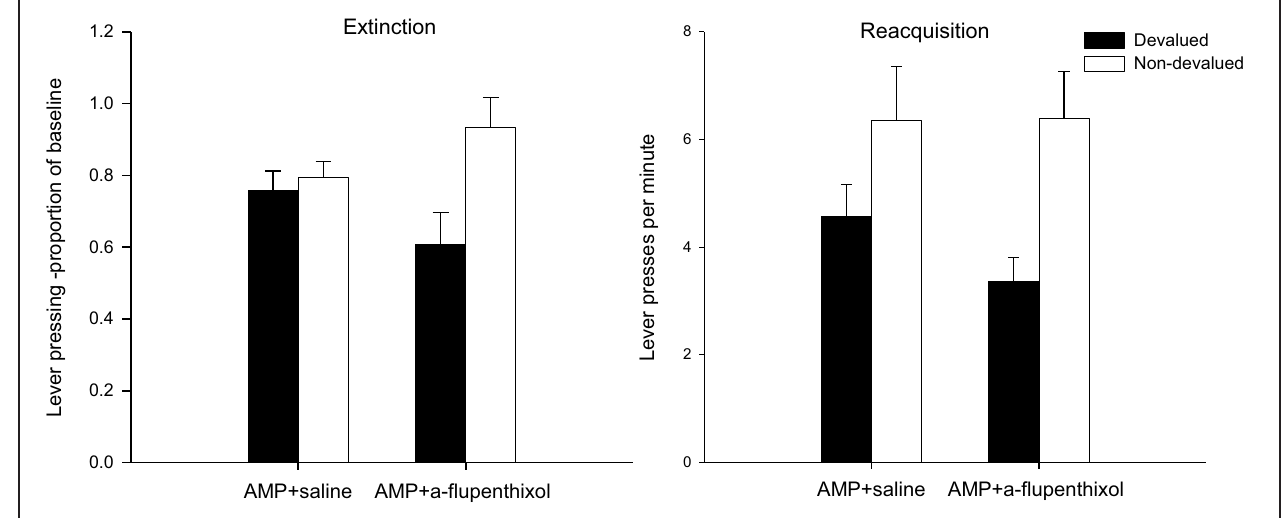
FIGURE 1 | Effect of α -flupenthixol following amphetamine sensitization on sensitivity of lever pressing to reward devaluation by LiCl-induced nausea. Mean lever presses per minute as a proportion of baseline ( ± SEM)